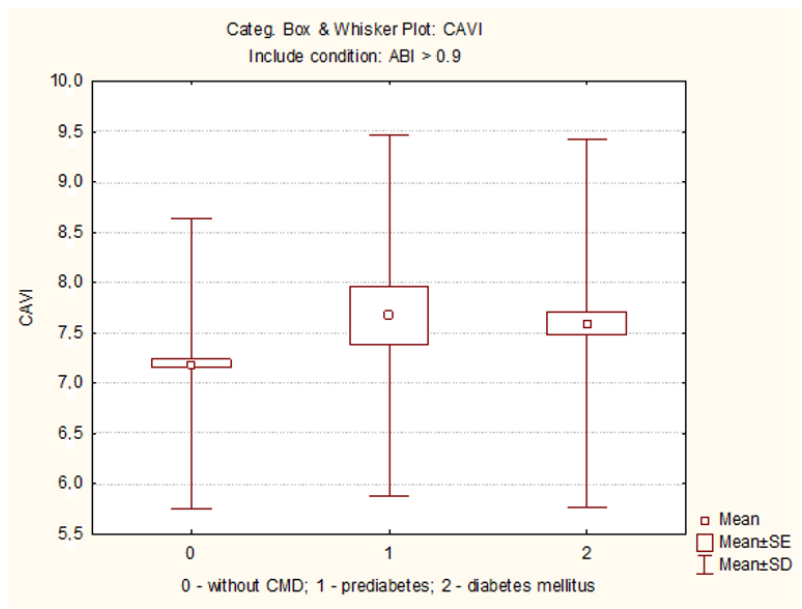
Figure 2. CAVI in groups with normoglycemia, prediabetes and diabetes. CAVI — cardio-ankle vascular index; p = 0.051 compared prediabetes to the normoglycemia group; p = 0.0002 compared diabetes to the normoglycemia group.